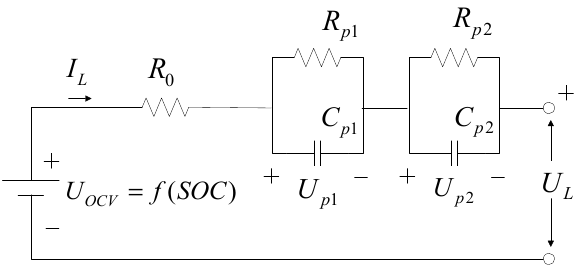
Figure 1. The dual polarization model of a lithium-ion battery.